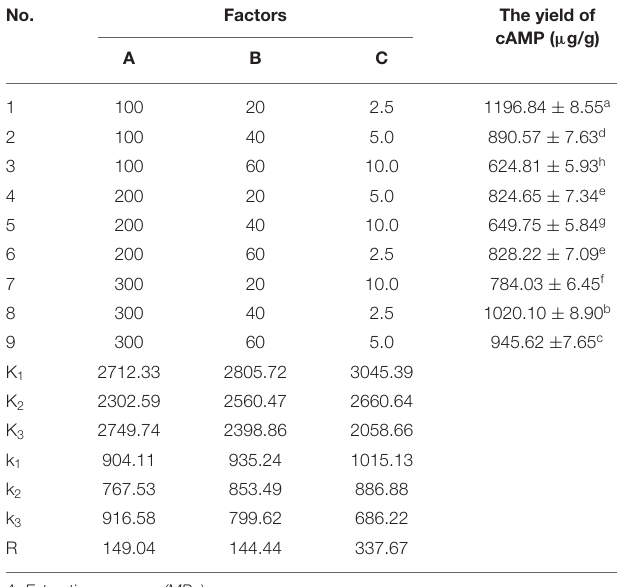
TABLE 1 | The orthogonal experiment design and results of ultra-high pressure extraction (UHPE). No. Factors The yield of